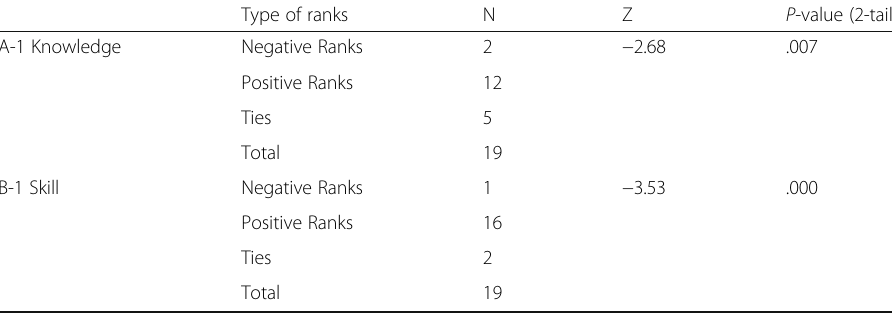
Table 2 Wilcoxon Signed Ranks tests between the pre- and the post-project